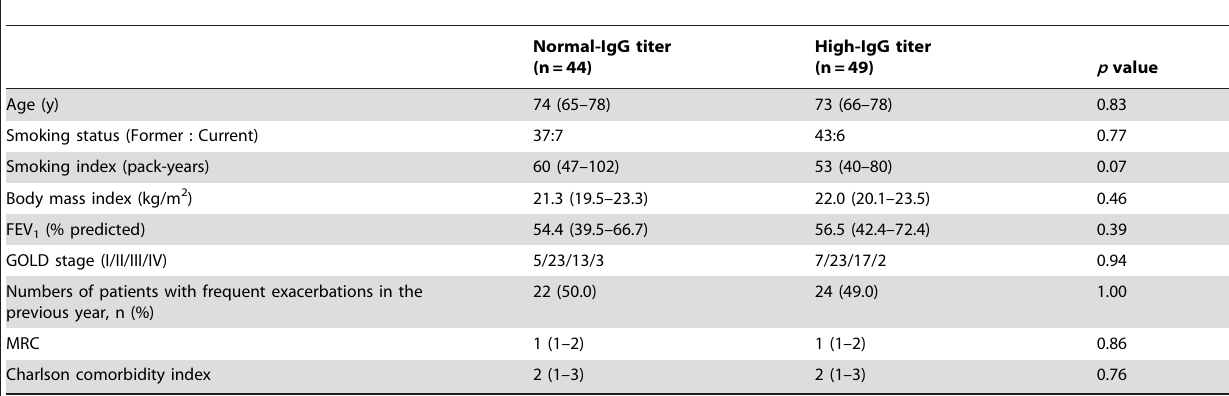
Table 2. Comparison of baseline characteristics between patients with normal and higher IgG titer against Porphyromonas